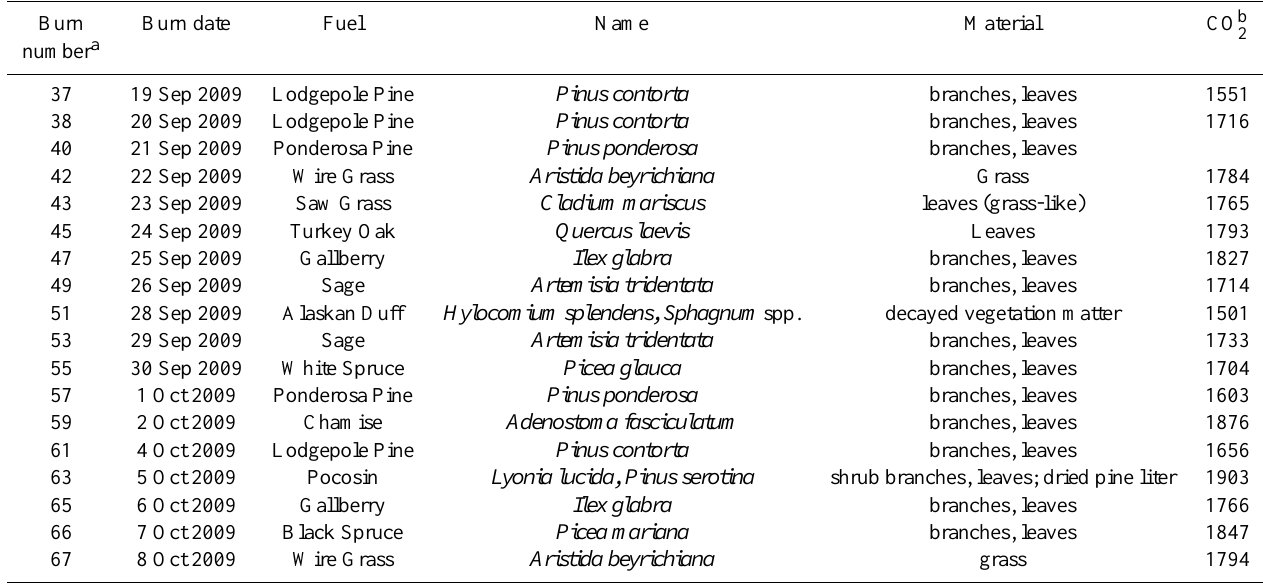
Table 1. Primary emission factors measured in the combustion chamber.